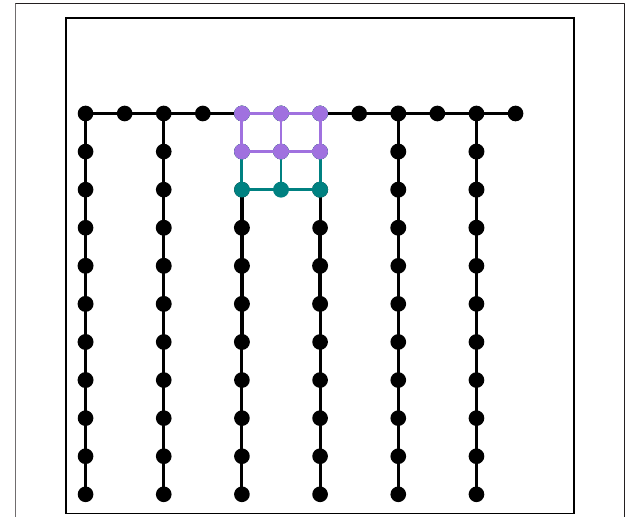
FIGURE 2 | New bonds (green) created by adding a new atom next to a rigid cluster (purple) in a square